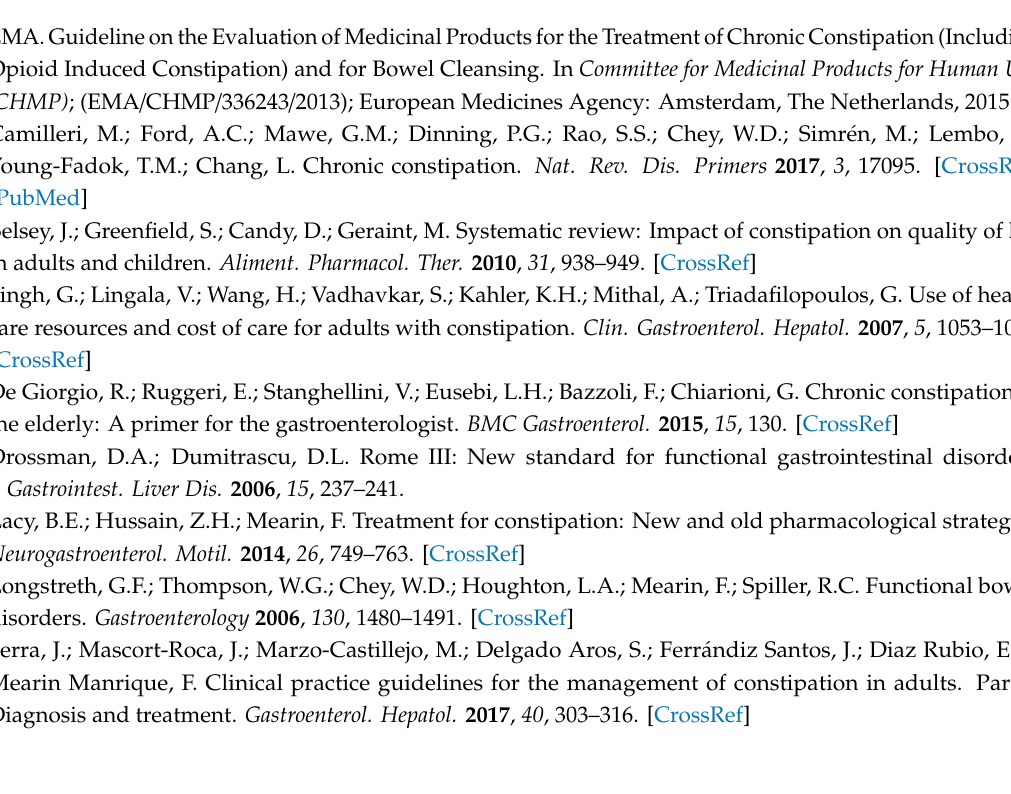
Figure S1: Bowel movement frequency by visit- ITT population ( N = 172) over time, Table S1: List of Investigators and Clinics, Table S2: Formulation of IPs, Table S3: Summary of Relevant Medical History and Surgical History - ITT Population ( N = 172), Table S4: Summary of Concomitant Medications- Safety Population ( N = 172), Table S5: Table S6: Summary of Adverse Events- Overall summary- Safety Population ( N = 172), Table S7: Summary of Treatment Emergent Adverse Events- Overall summary- Safety Population ( N =